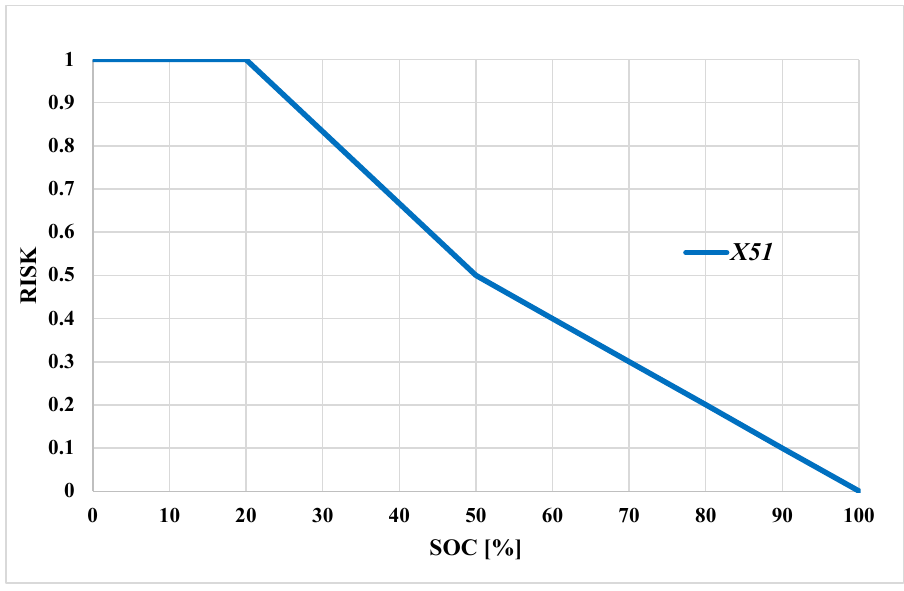
Figure 4. Relation between SOC and risk value.